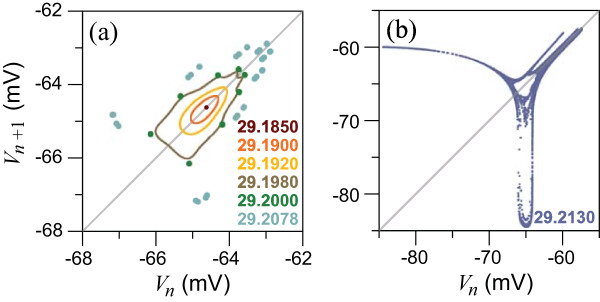
Recurrence maps for the consecutive minima of the membrane potential
for the indicated values of the parameter
gK1. (b) Recurrence map for
gK1 = 29.213 nS (corresponding to chaotic
bursting oscillations shown in Figure 2E) emerging via the breakdown of
the torus shown in (a). Note the distinct scales used in (a)
and (b) (the original torus would be situated in the middle
section of the map shown in (b)). Other parameters are the same
as in Figure 2.